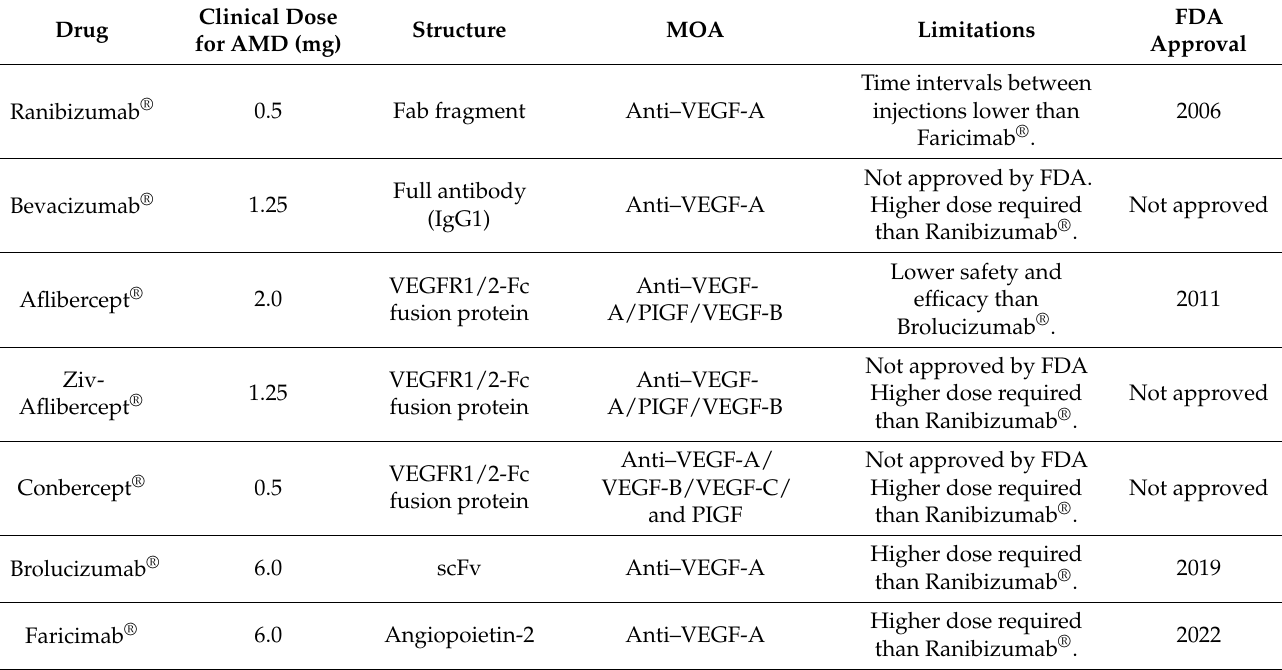
Table 1. Anti-VEGF agents proposed for AMD treatment in